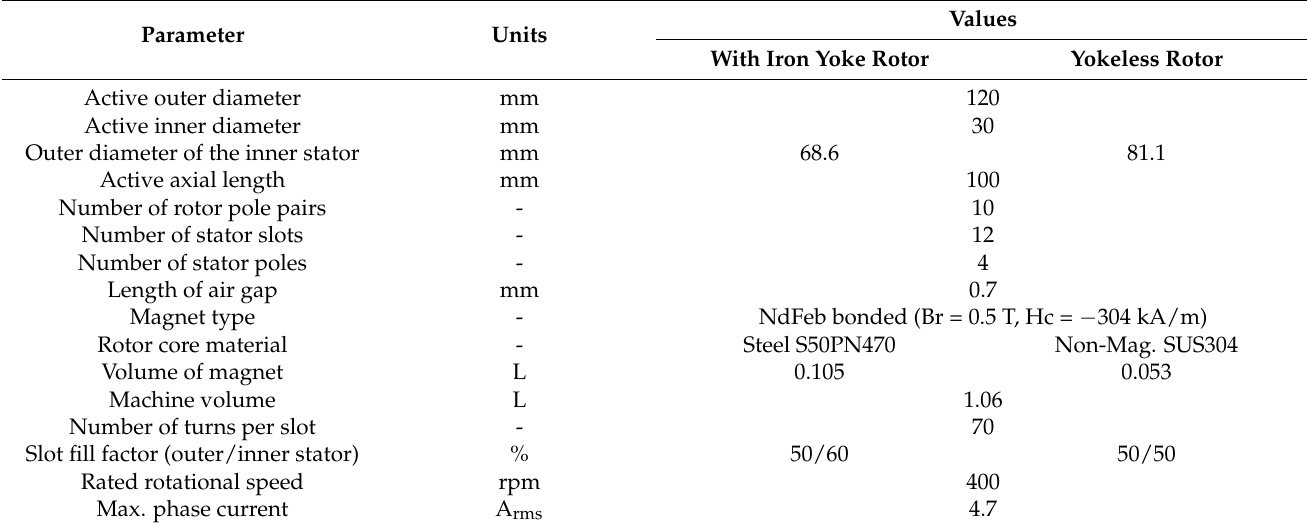
Table 1. Specifications of DARF-PMVM models.